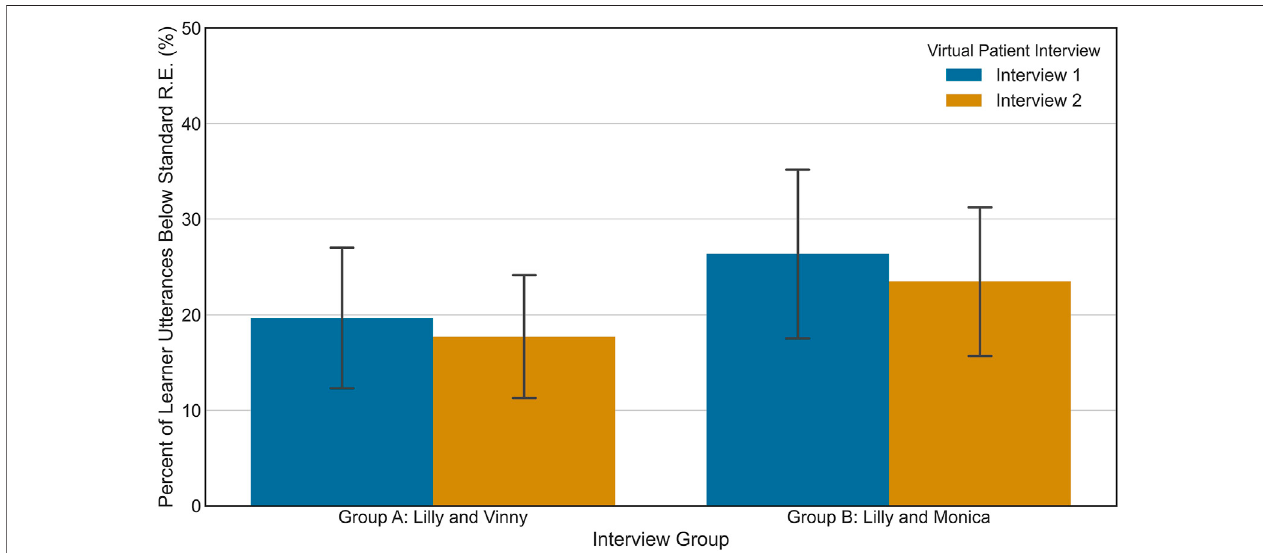
FIGURE 6 | The means and standard deviations of percent of learner utterances below standard reading ease for students in the Message Production Trends study.